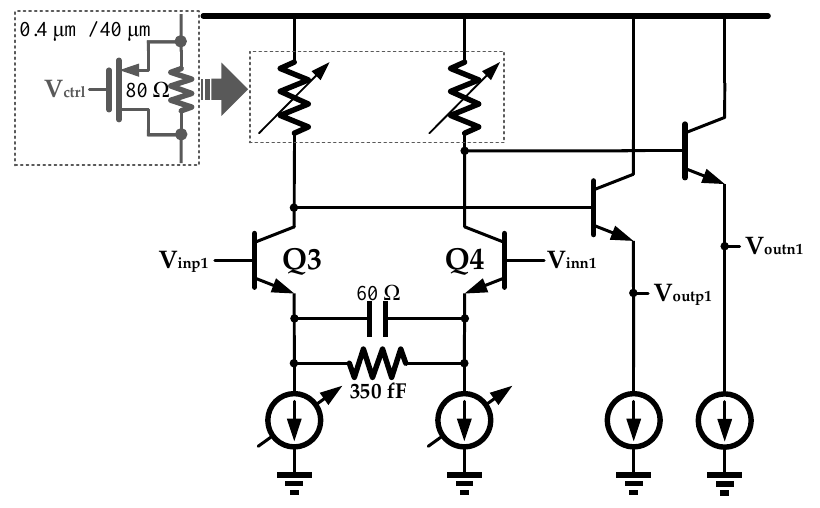
Figure 9. A schematic of the variable-gain amplifier.